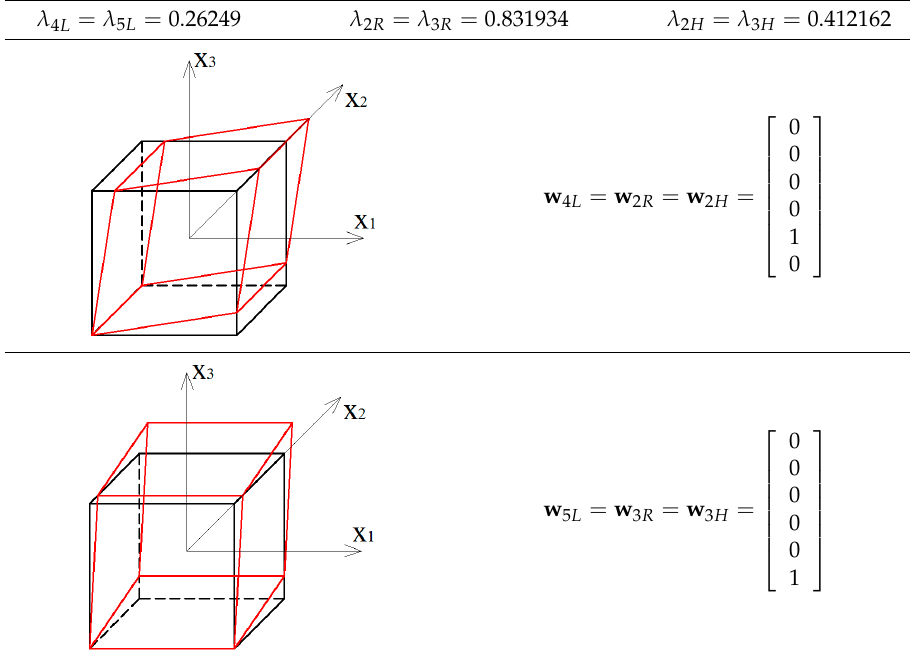
Table 4. High shear modes of deformation.